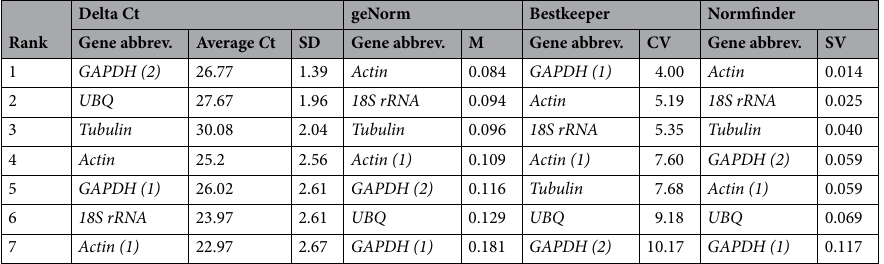
Table 2. Variation in the expression stability of seven candidate reference genes determined using the 2 −ΔΔCt method, geNorm, Bestkeeper, and Normfinder. RT-qPCR data were analyzed at different developmental stages, at different incubation temperatures, and during interaction with pitaya .